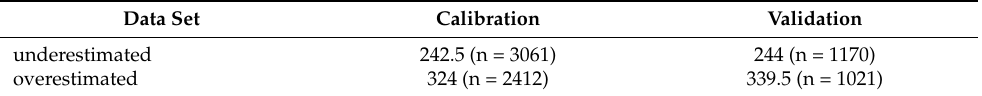
Figure 5. Solar radiation estimated by proposed model at Cusco station versus measured values in calibration and validation sets. Table 9. RMSE values (J · cm − 2 · day − 1 ) and number of data points belonging to under- and overesti- mation sets in calibration and validation phases using proposed model.